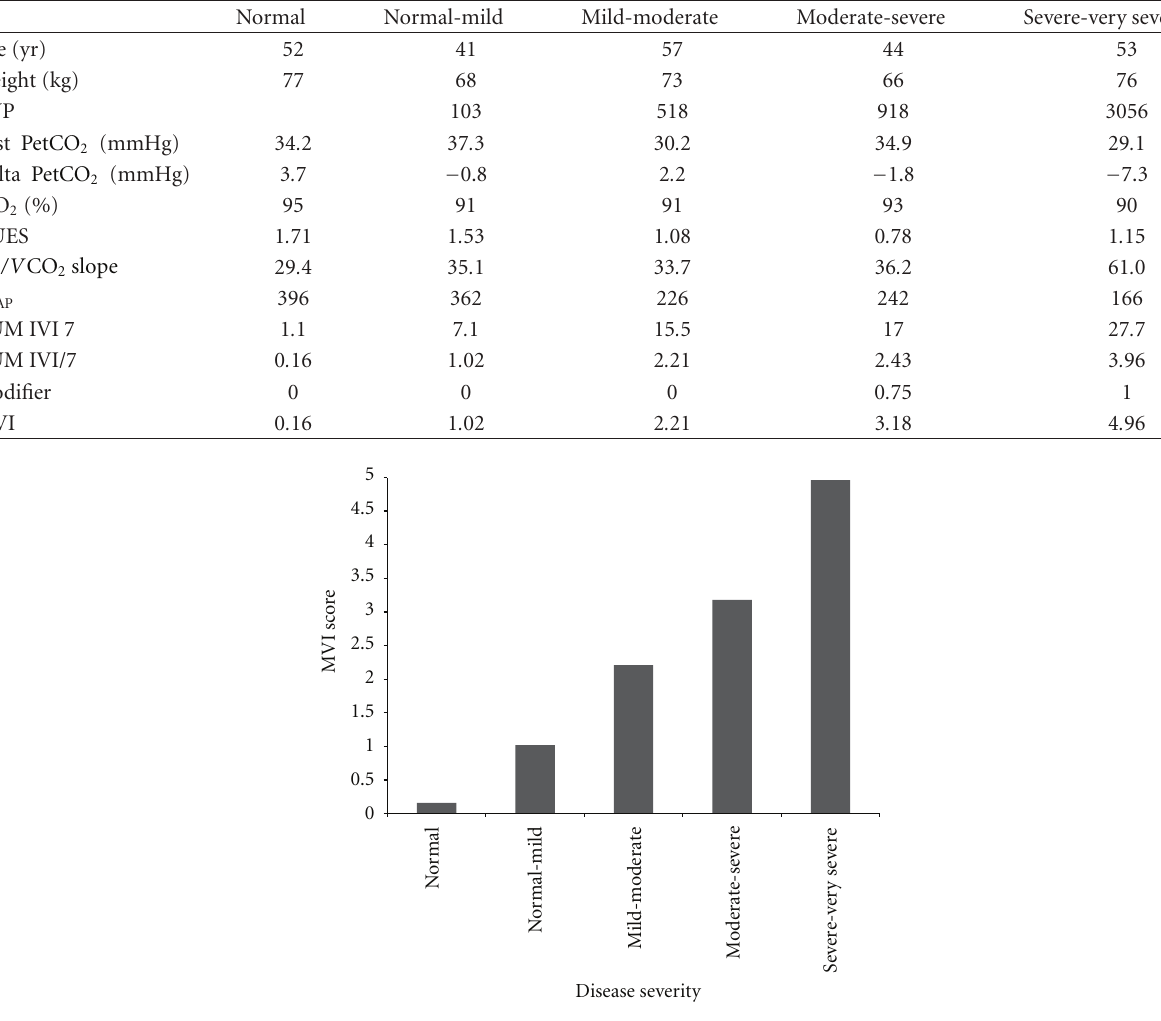
Figure 4: Final model with examples of PAH patients according to gas exchange severity.